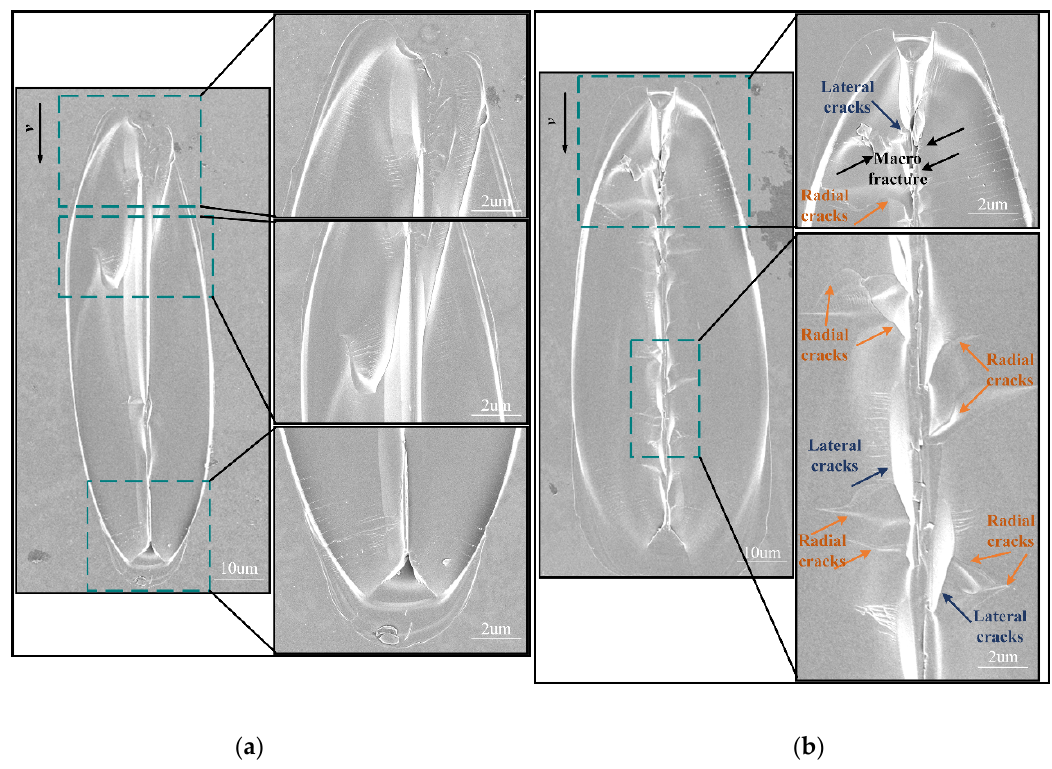
Figure 7. Images of scratch grooves in face-forward scratching: ( a ) 600 nm scratch depth; ( b ) 900 nm scratch